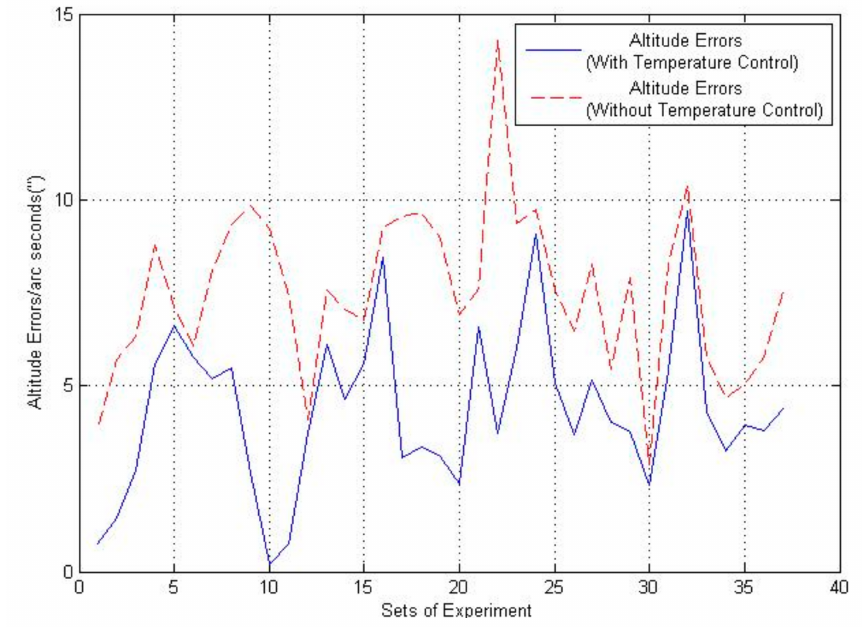
Figure 9. Altitude